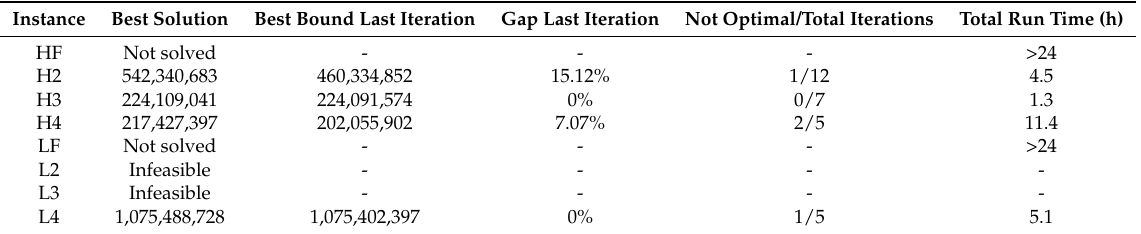
Table 3. Computational